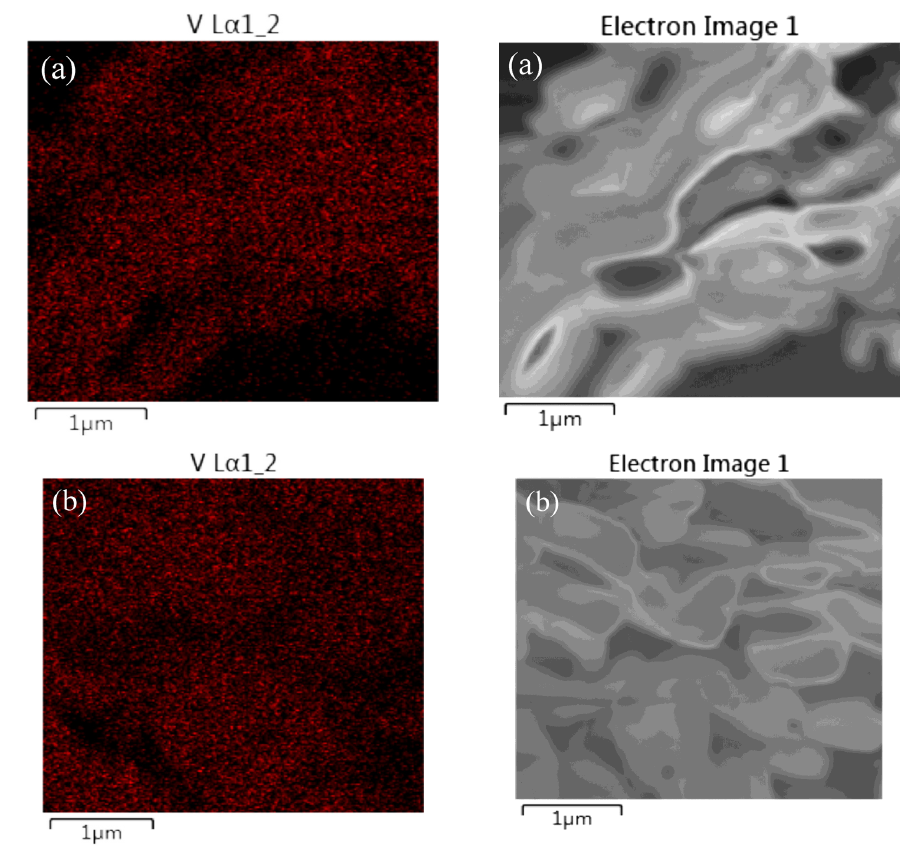
Figure 4. EDX elemental mapping of vanadia (V) (left column) and corresponding SEM images (right column) of ( a ) 3% V/SBA and ( b ) 7% V/SBA.